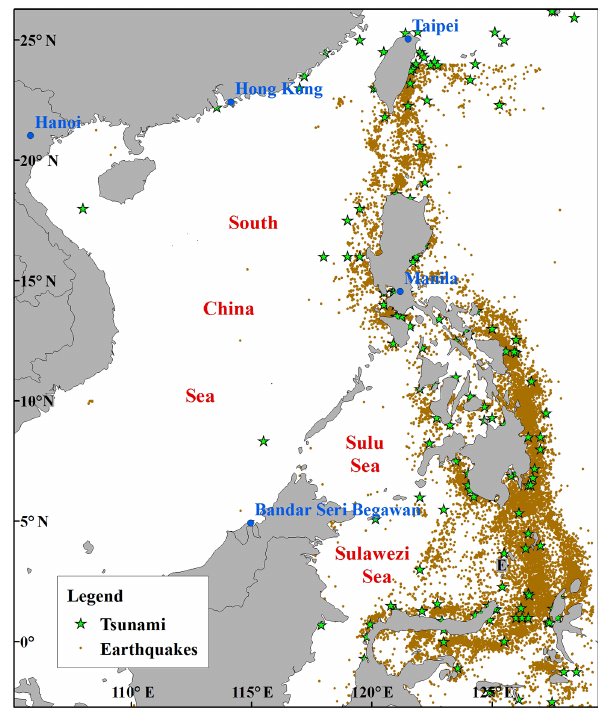
Figure 2. Location map of the study area. Figure 3. Location of the South China